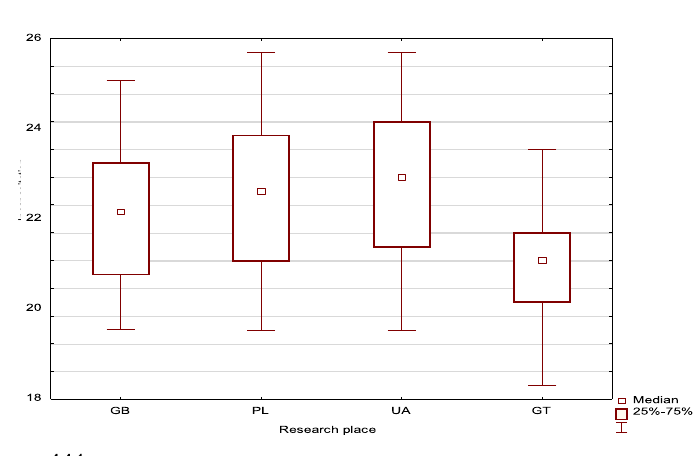
Note: Sample n = 441. Figure 7. Distribution of results for violence in individual